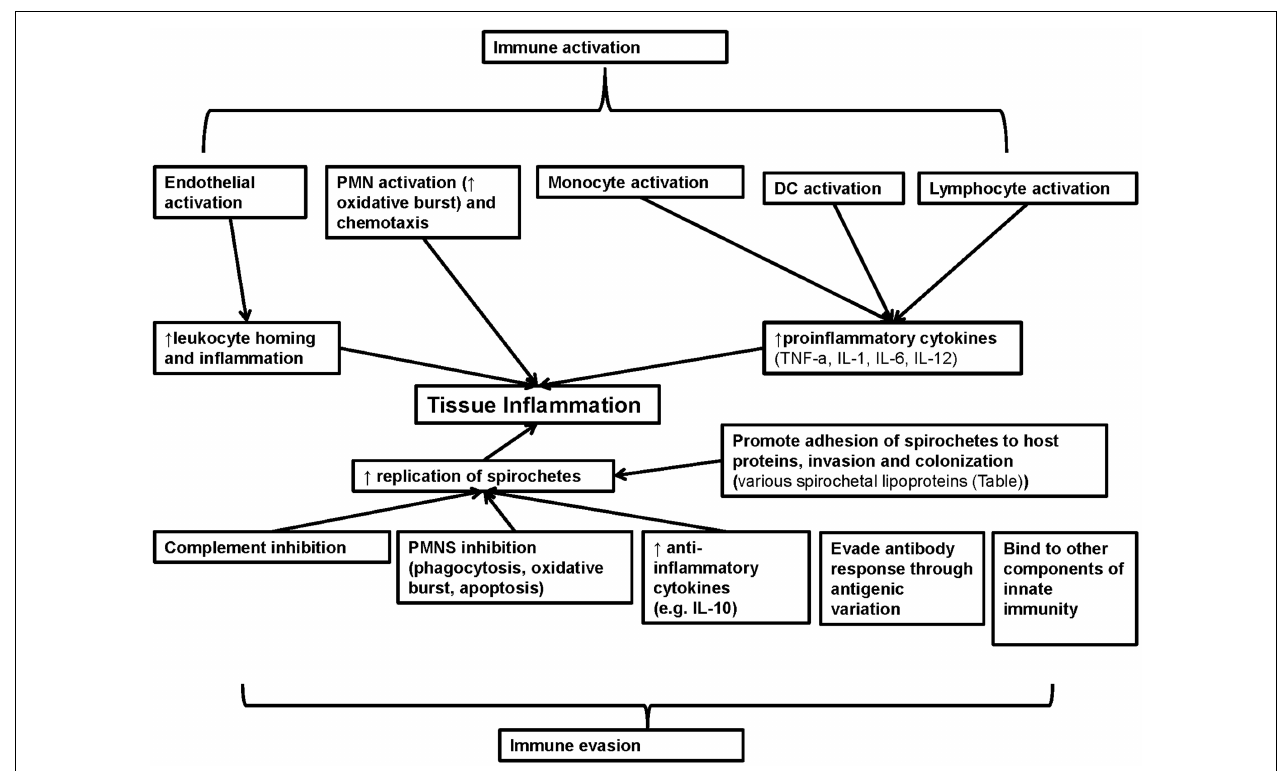
FIGURE 2 | Summary of the role of known spirochetal lipoproteins in regulation of immunity . Spirochetal lipoproteins have two